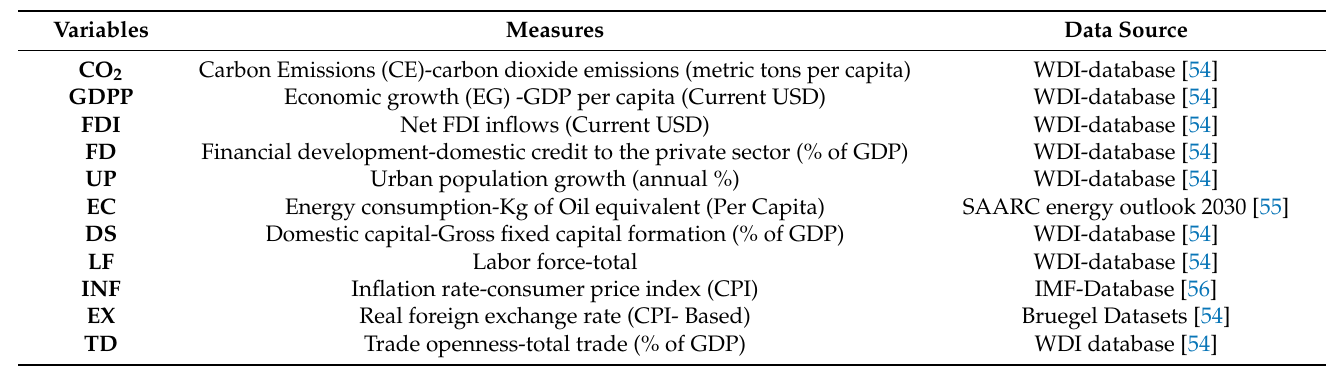
Table 1. Variables Measurement.